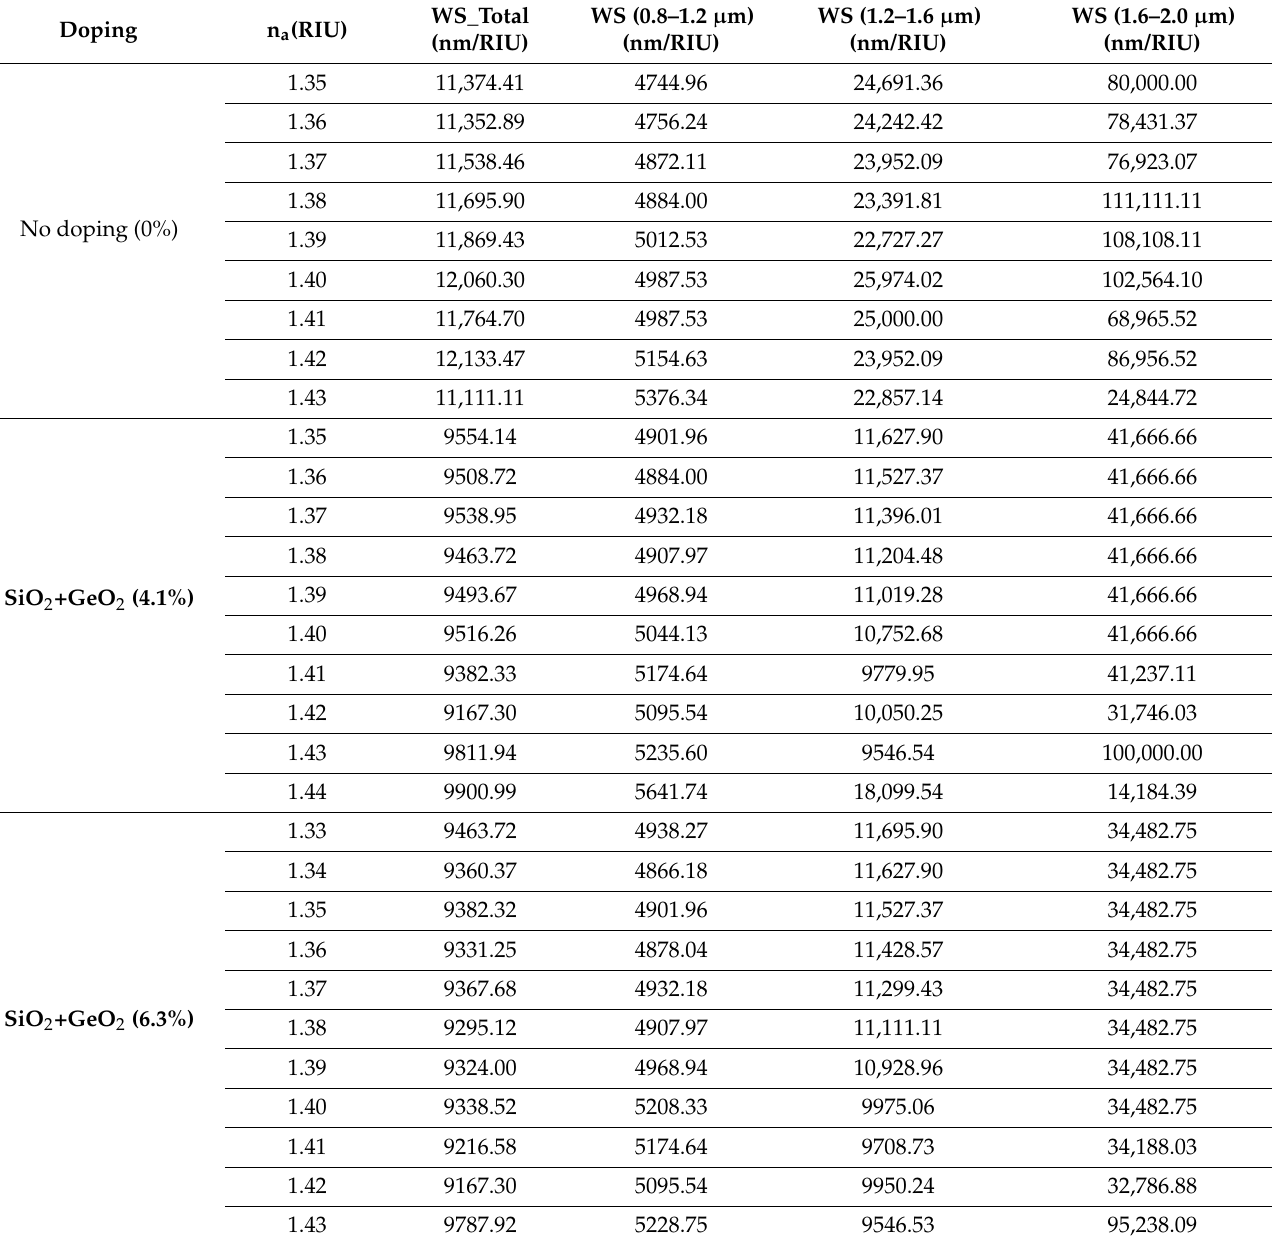
Table 3. Details of the sensitivity of the proposed sensor, for the various dopings and analytes.